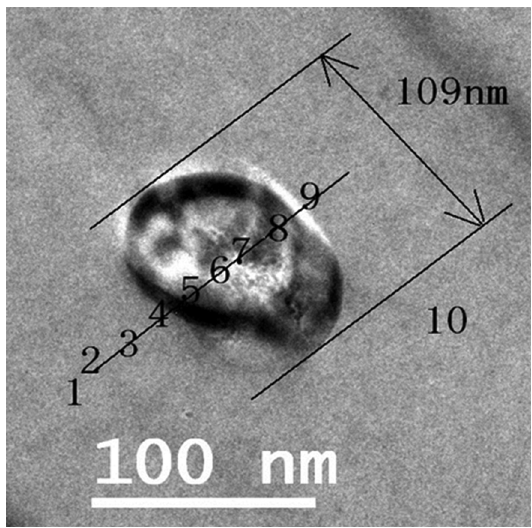
Figure 10. Precipitated phase in 4µm Fe-1.3Mn alloy powder and test position of